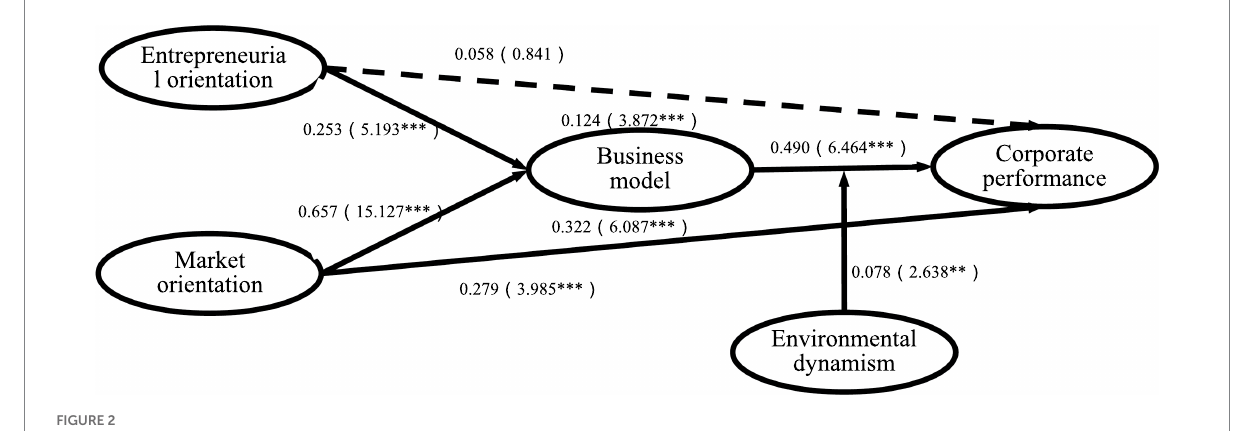
FIGURE 2 Path testing result. * p < 0.05, ** p < 0.01 and *** p <